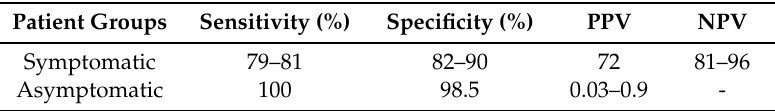
Table 1. Summary of pancreatic cancer detection using carbohydrate antigen 19-9 (CA 19-9) (>37 U/mL)